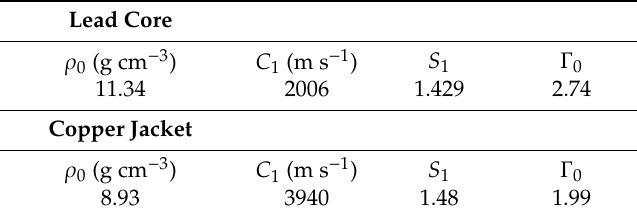
Table 1. Values for lead core and copper jacket based on Mie–Gruneisen equation of state (EOS).